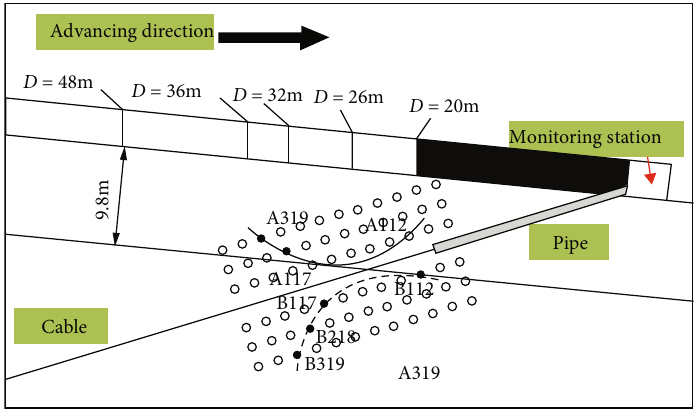
Figure 13: Schematic diagram of fl oor failure